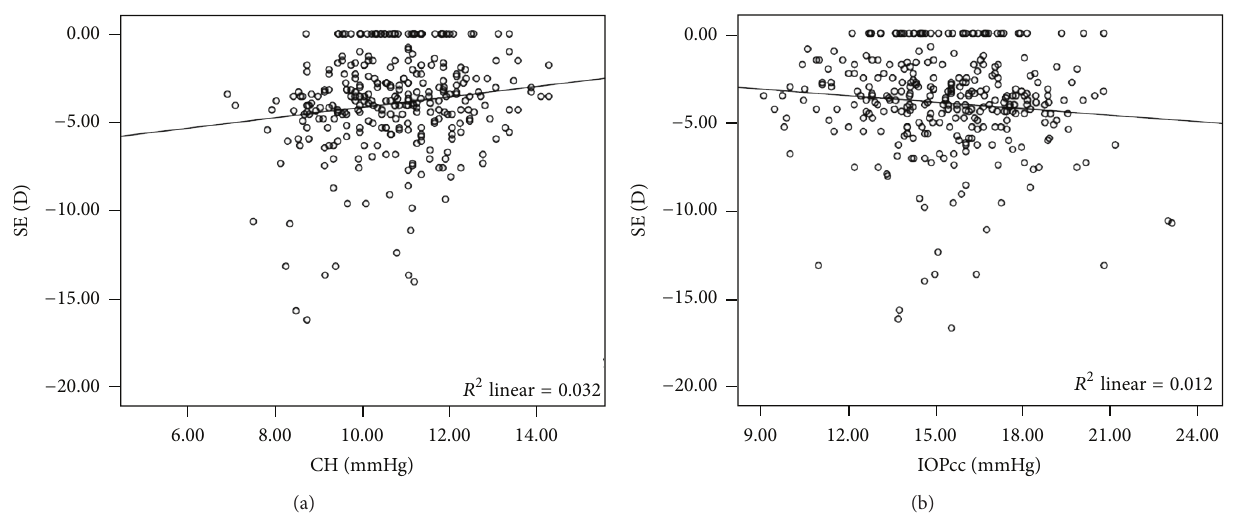
Figure 2: Correlation between spherical equivalent (SE) and (a) corneal hysteresis (CH) and (b) corneal compensated intraocular pressure